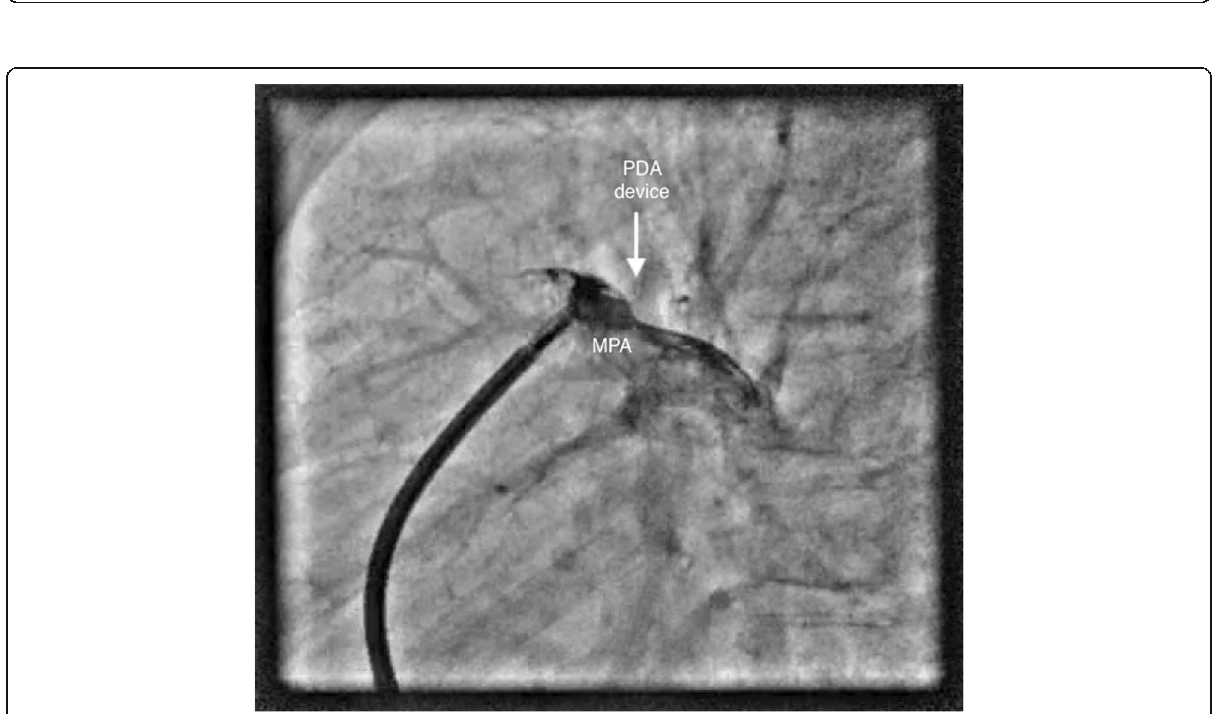
Fig. 2 Contrast injection in right anterior oblique (RAO) view 30° with pigtail catheter crossing from the main pulmonary artery to the descending aorta depicting conical-shaped PDA